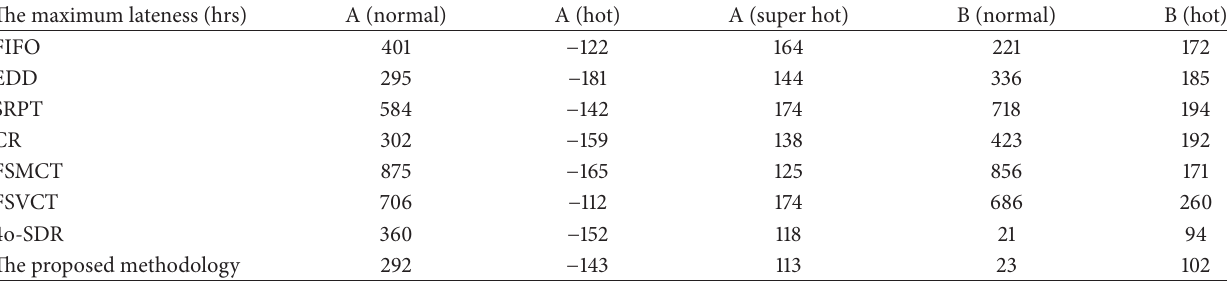
Table 8: The performances of various approaches in the maximum